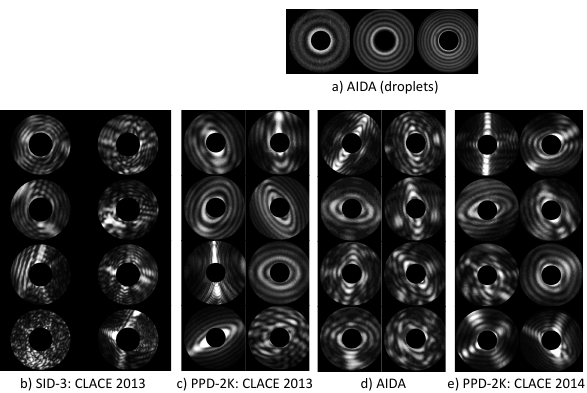
Figure 12. Randomly selected droplet scattering patterns recorded by the PPD-2K at the AIDA cloud chamber (RICE01 campaign, experiment 09) (a) and randomly selected ice crystal scattering pat- terns recorded by the SID-3 directly sampling ambient air during CLACE 2013 between 18:20 and 18:30LT on 12 February 2013 (b) ; by the PPD-2K downstream of the ISI during CLACE 2013 between 19:55LT on 12 February 2013 and 01:20LT on 13 Febru- ary 2013 (c) ; by the PPD-2K directly connected to the AIDA cloud chamber during the final stage of an ice cloud experiment (RICE02 campaign, experiment 18) (d) ; and by the PPD-2K downstream of the ISI during CLACE 2014 between 09:20 and 11:00LT on 14 February 2014 (e) . The patterns display the distribution of scat- tered light measured between 0 and 26 ◦ relative to the forward di- rection. The black area in the centre of the SID-3 and PPD-2K scat- tering patterns is due to the beam dump of the SID-3 and